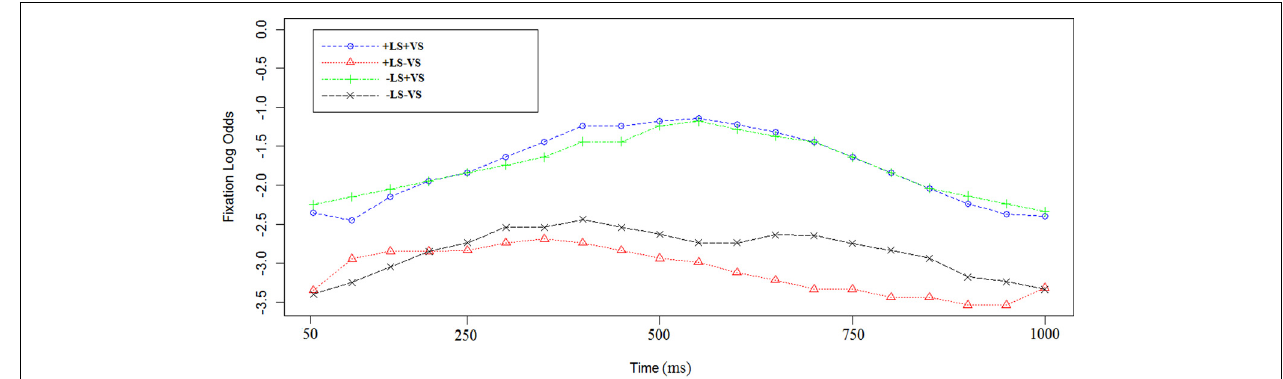
FIGURE 3 | Log odds of fixations in sentence b. in the four experimental conditions. In sentence b the entity is not repeated. The logs odds of fixation are referred to the fixations to the sentence target